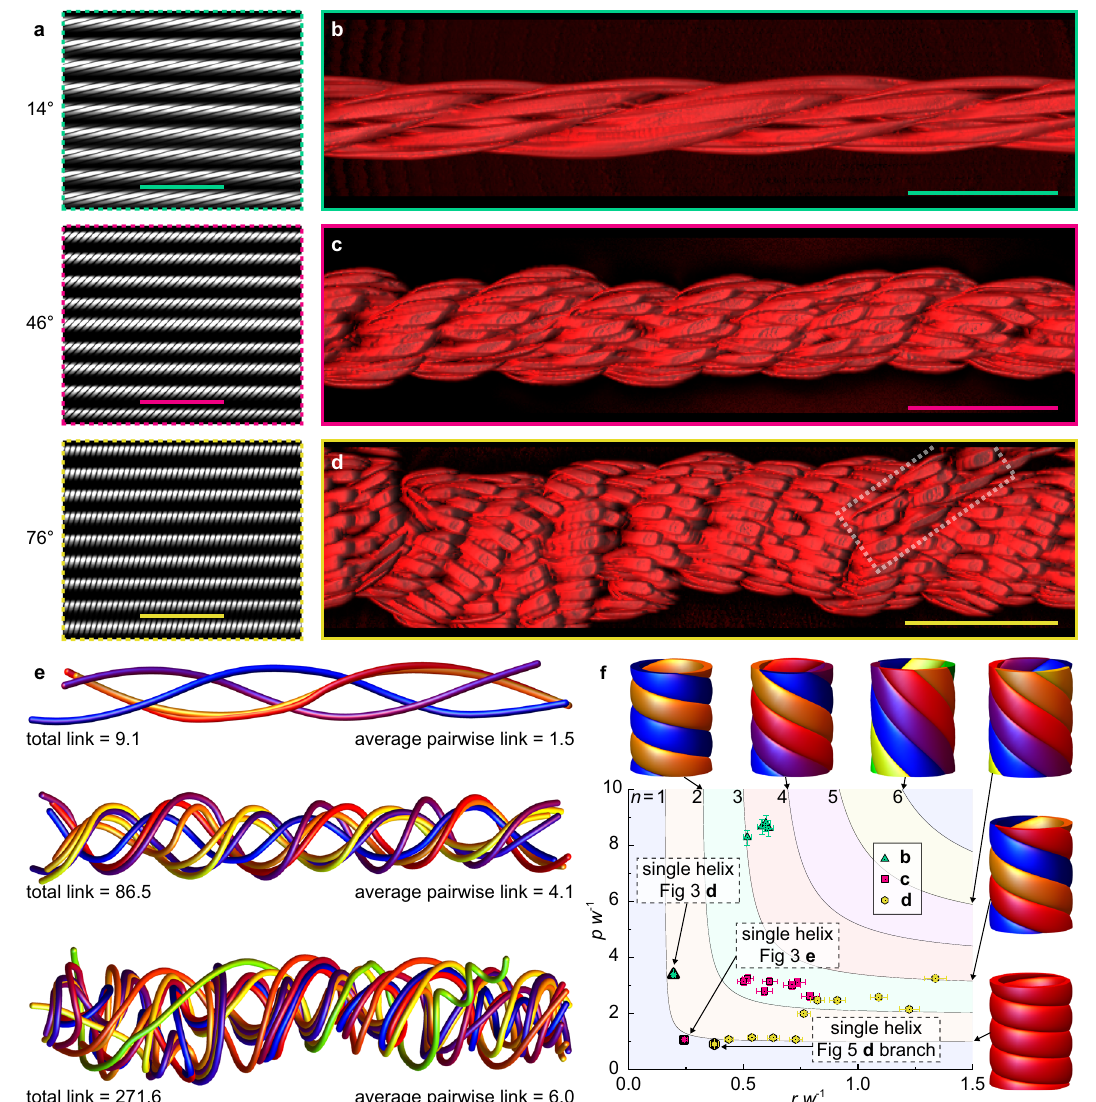
Fig. 5 | Coiled MSP bundles. a Fluorescence micrographs of substrate-bound, aligned MSP arrays with ϕ =14° (top), 46° (center), and 76° (bottom); scale bars 200 μ m. b – d 3D-reconstructed confocal z-stacks (right) of bundles arising from coincident and proximal MSP coiling with ( ϕ ,n ) = (14°,4) ( b ), (46°,7) ( c ), and (76°,10) ( d ). The dashed box in d denotes a branch with n =1; scale bars b – d 100 μ m. e smoothedrenderingofconstituentMSPcenterlinesinbundles b – d ; linking number increases with n . f Width-normalized pitch as function of width-